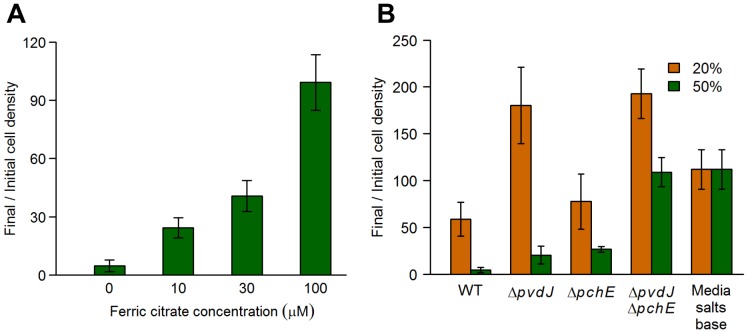
Iron-limitation by P. aeruginosa siderophores inhibits E. coli growth.
E. coli cells were grown in the presence of P. aeruginosa spent media and the cell density was determined before and after 16 hours of growth. Data are the means from at least 5 replicates. Error bars represent standard deviation. (A)
E. coli cells were grown in the presence of 50% (v/v) P. aeruginosa spent media supplemented with increasing levels of ferric citrate. Data from each concentration were significantly different from the preceding concentration (q < 0.005) as determined by a one-sided Mann-Whitney U test followed by the Benjamini-Hochberg procedure for multiple testing correction. (B)
E. coli cells were grown in the presence of 20% or 50% (v/v) spent media from various P. aeruginosa wild-type and mutant strains. All mutant and control data shown (except for ΔpchE at 20%) were significantly different from WT (q < 0.005) as determined by a one-sided Mann-Whitney U test followed by the Benjamini-Hochberg procedure for multiple testing correction (this correction included the mutant strains showed in Figs 5 and 7A). Spent media from the ΔpvdJ and the ΔpvdJ ΔpchE mutants supported more growth than the media salts base control, likely due to the presence of unused nutrients or P. aeruginosa signaling molecules in the spent media.